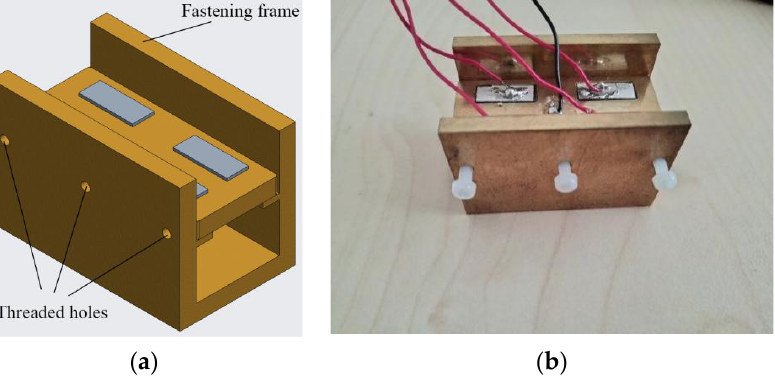
Figure 4. Structure of the clamp: ( a ) Three-dimensional model; ( b ) Actual machined support frame.